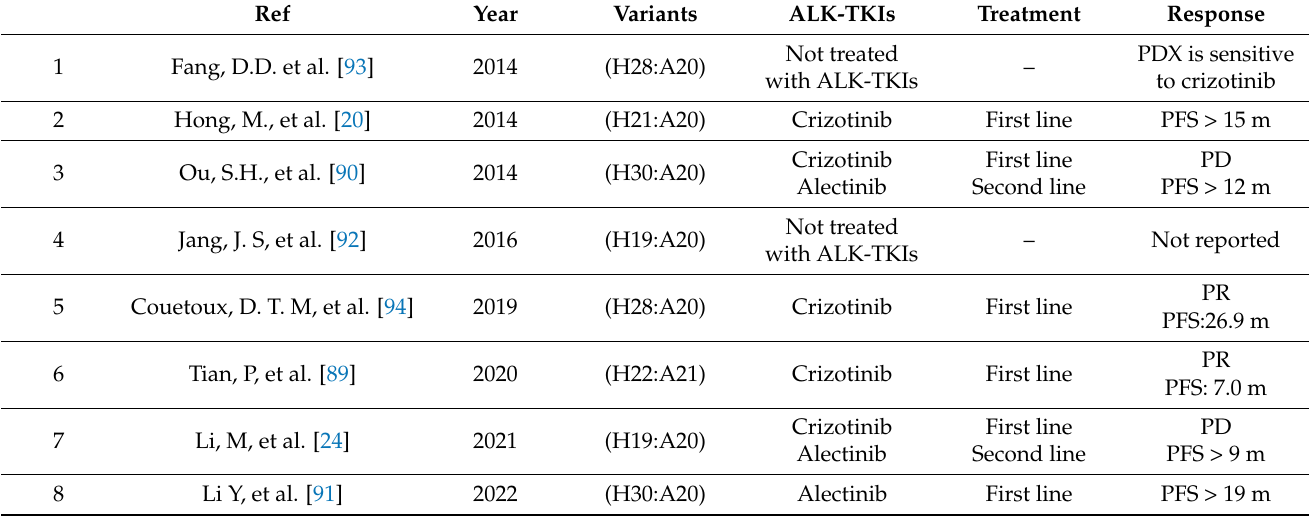
Table 3. Published details of HIP1-ALK-positive NSCLC patients treated with